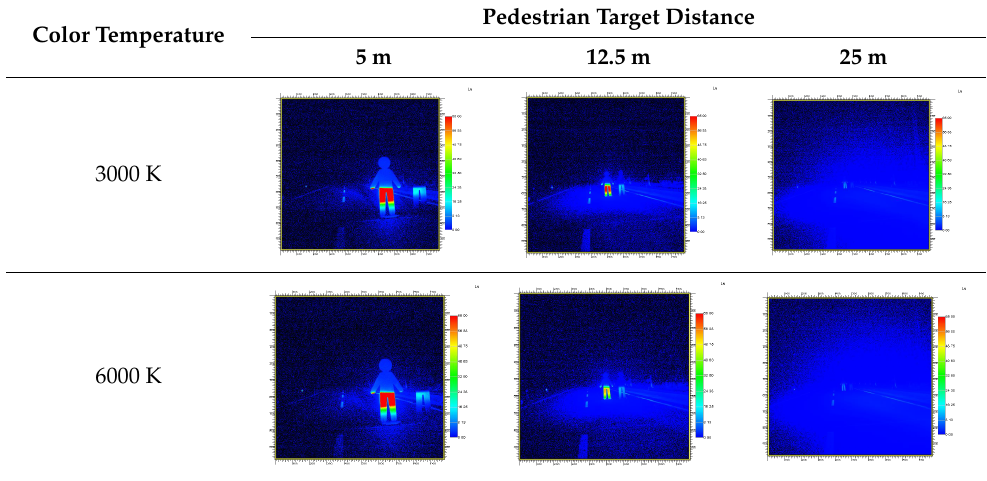
Table 6. Comparison of luminance by target distance and color temperature (fog 200 m).